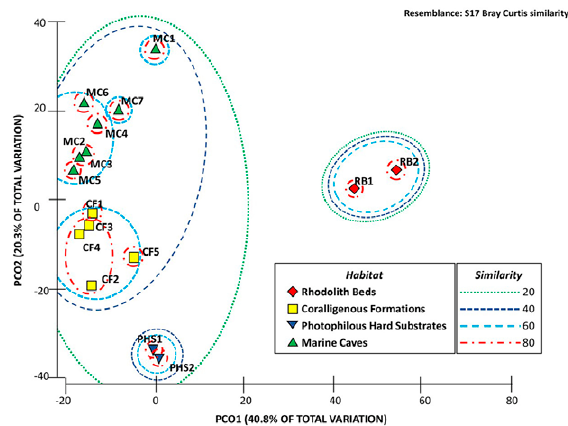
Fig. 4. – Principal coordinates analysis based on a Bray-Curtis sim- ilarity resemblance matrix on untransformed data of sponge assem- blages from the studied